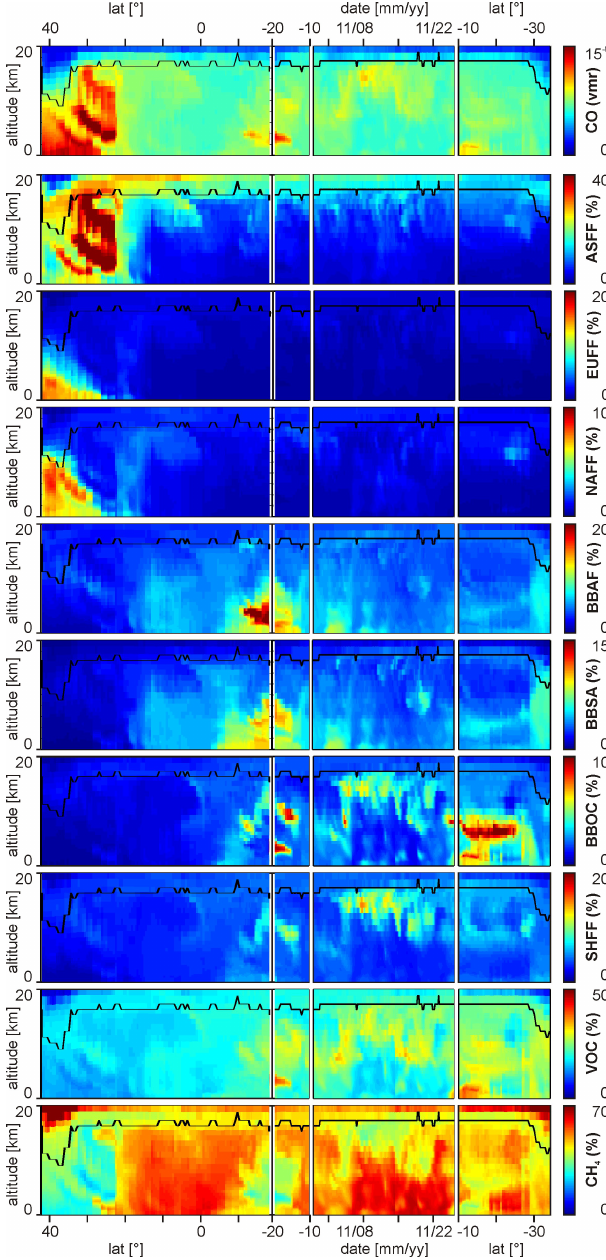
Fig. 6. Total CO vertical profiles (top) simulated with the GEOS- Chem tagged-CO simulation and relative contributions of various tracers from different trace regions (ASFF: Asian fossil fuel, EUFF: European fossil fuel, NAFF: North American fossil fuel, BBAF: African biomass burning, BBSA: South American biomass burn- ing, BBOC: biomass burning from Oceania, SHFF: Southern Hemi- spheric fossil fuel, VOC: volatile organic compounds, CH 4 : oxida- tion of methane). The black line in each graph indicates the model tropopause